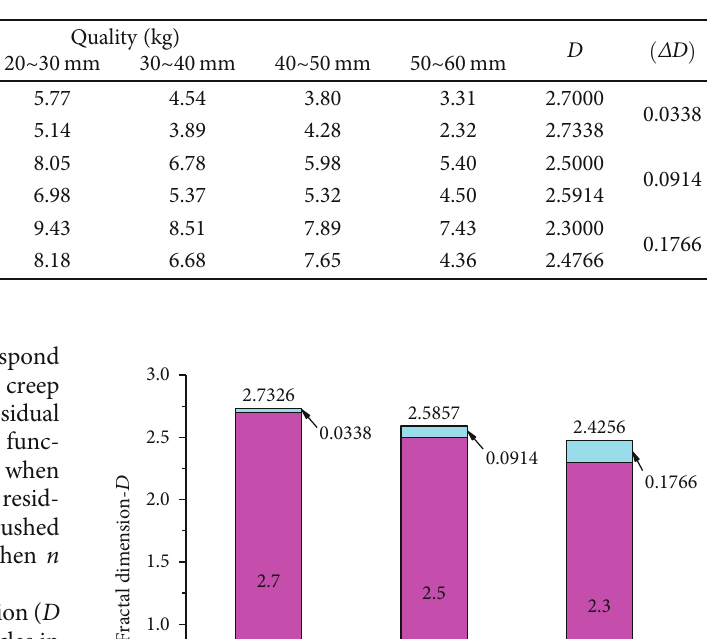
Figure 10: Time correlation curves of the amount of residual crushing expansion and void fraction for caving sandstone samples of di ff erent grain compositions (axial stress of 3.5 MPa). Table 5: Grain size distribution and fractal dimensions of crushed sandstone with di ff erent grain compositions before and after compression (axial stress of 3.5MPa).